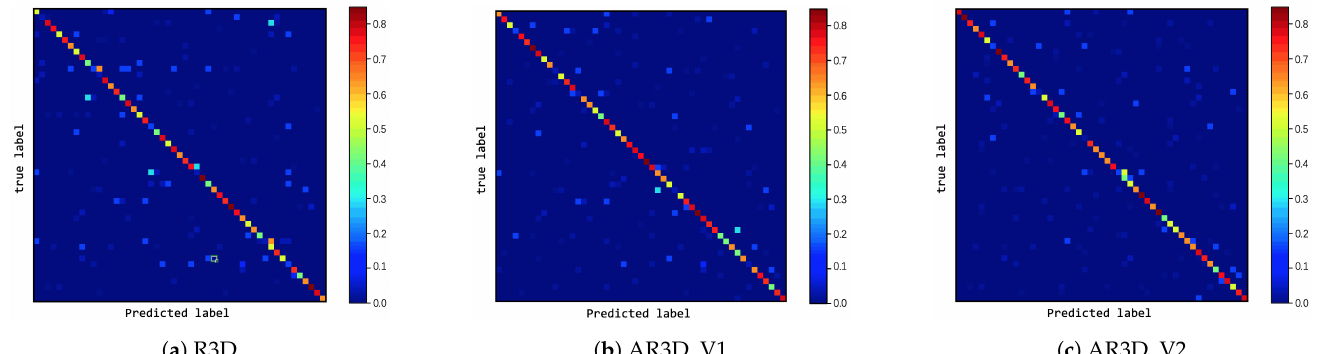
Figure 11. Confusion matrix of three proposed models on